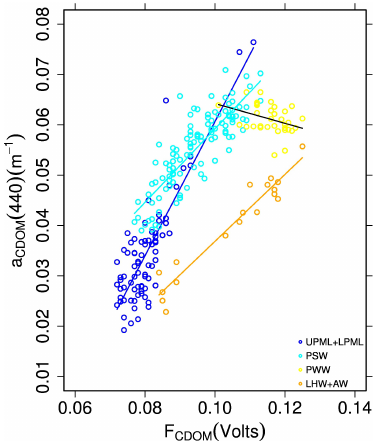
Fig. A3. Relationship between a CDOM (440) and CDOM fluores- cence, f CDOM , for water masses of the Southern Beaufort Sea. Data points for UPML + LPML, PSW, PWW, and LHW + AW are shown as blue, cyan, yellow, and orange open circles,